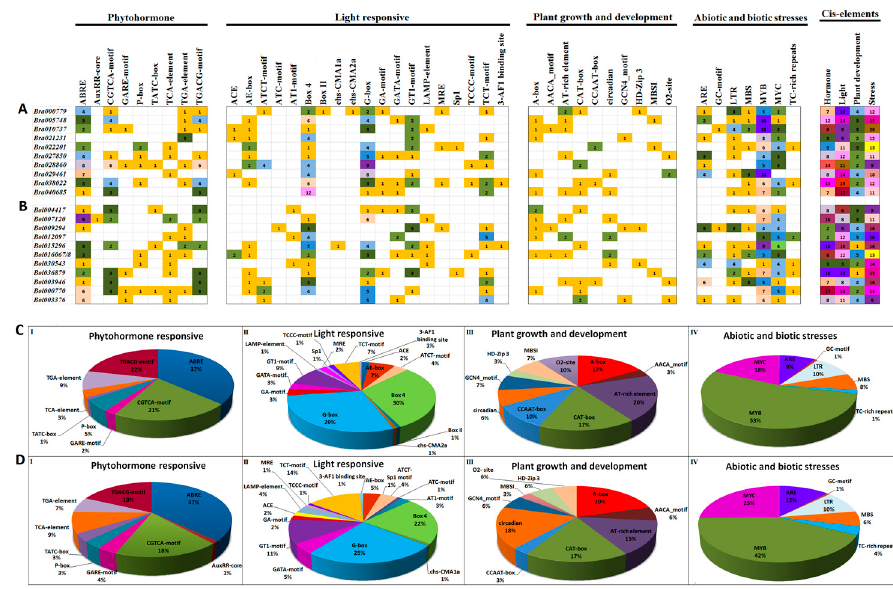
Figure 3. Putative cis-regulatory element analysis of the promoter region (2kb) of 10 B. rapa ( A , C ) and 11 B. oleracea ( B , D ) HECT genes. The numbers of different cis-regulatory elements identified in the promoter region of 10 B. rapa ( A , C ) and 11 B. oleracea HECT genes are shown by di ff erent colors and numbers in the grid. The sum of the cis-regulatory elements in each category was displayed with a differently colored histogram on the upper right side. The ratio of each identified cis-regulatory element in each category of B. rapa ( C ) and B. oleracea ( D ) was represented by pie charts.